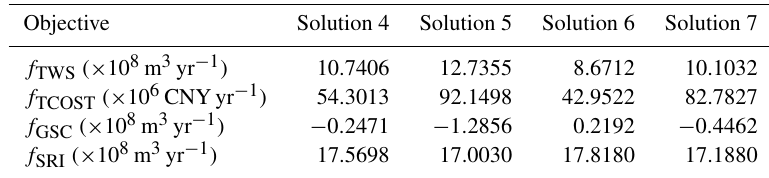
Figure 8. Identification of six interesting solutions (solutions 1–6) from the four-dimensional approximate Pareto set, and the green arrow is the preferred direction for each objective. Table 2. The objective values corresponding to several